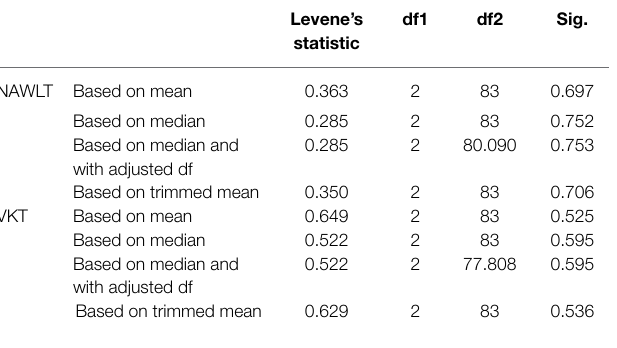
TABLE 2 | Test of homogeneity of variances for scores on pre-test.